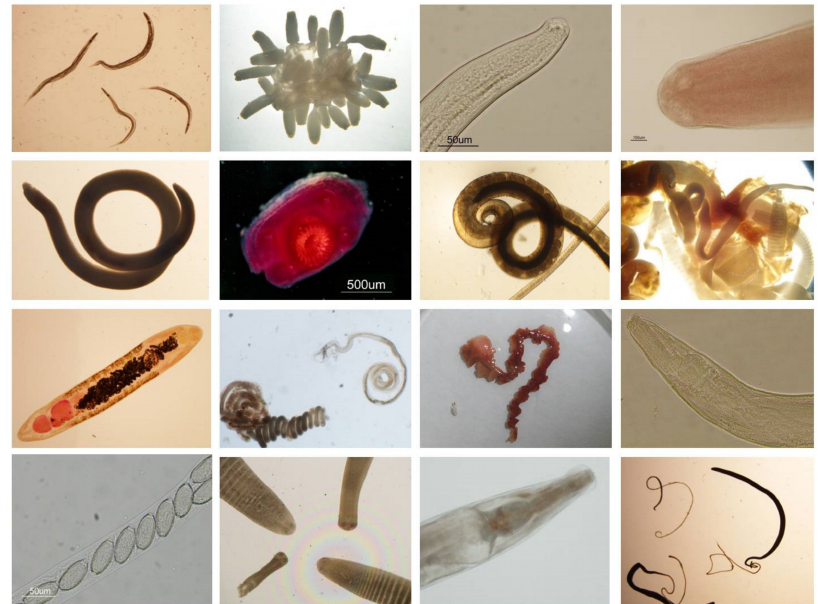
Figure 6. Microscopy photographs of some helminths found in the wood mice analysed. From left to right: 1st line, Syphacia frederici females, Taenia parva metacestode, anterior part of Eucoleus bacillatus , Pseudocatenotaenia matovi scolices; 2nd line, Mastophorus muris female, Taenia parva scolex section, caudal end of Trichruis muris male, Gallegoides arfaai strobila; 3rd line, Brachylaima sp. adult, Heligmosomoides polygyrus female and male, Taenia martis metacestode, anterior end of Syphacia frederici female; 4th line, eggs in the uterus of an Aonchotheca annulosa female, Gallegoides arfaai and Catenotaeniidae Gen. sp. scolices, anterior end of Aspiculuris tetraptera female, Trichuris muris